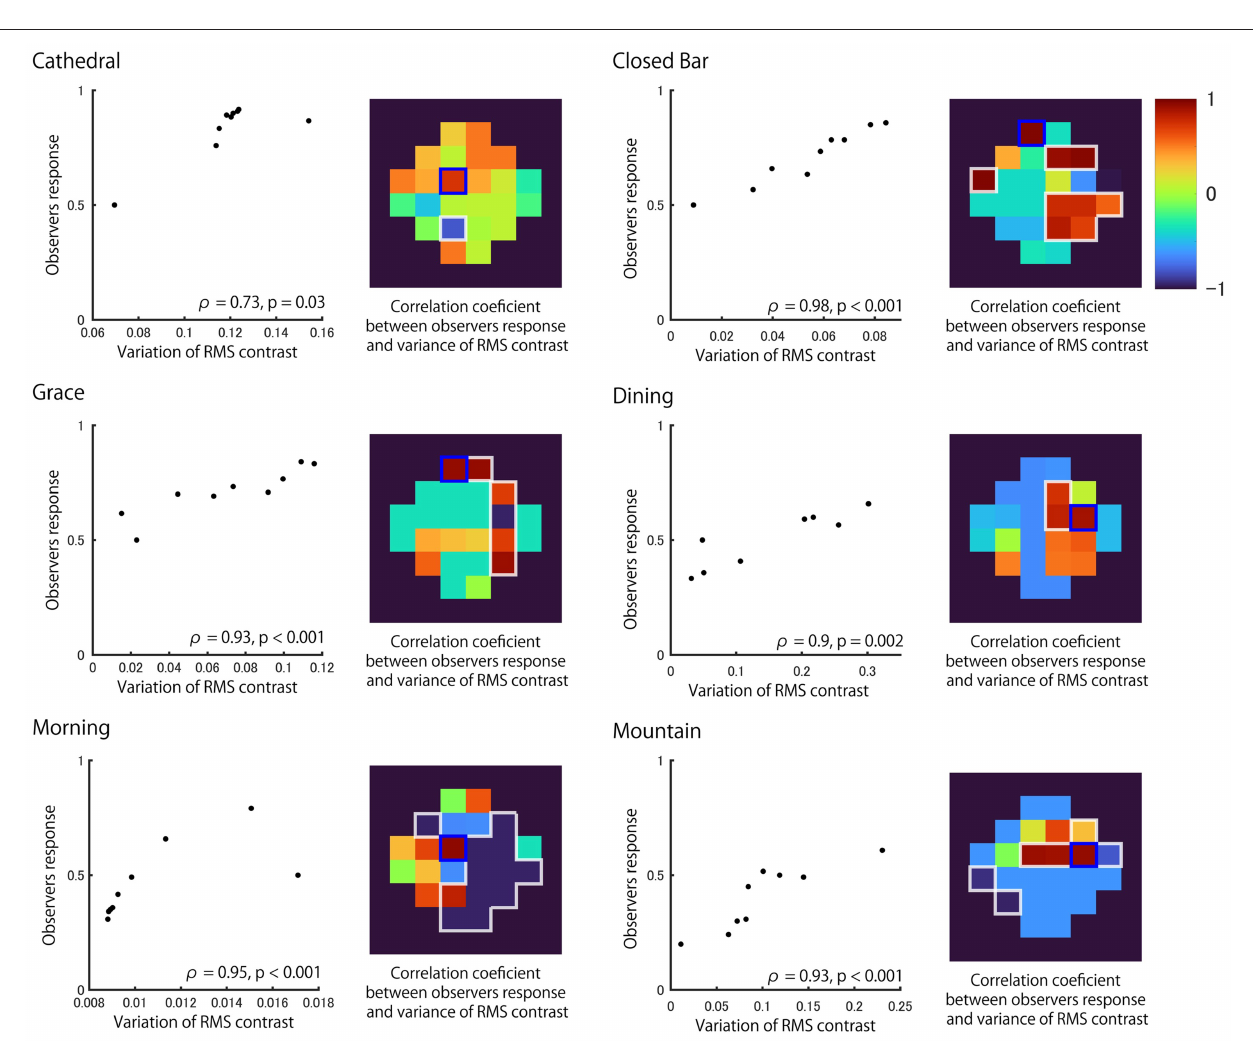
Frontiers in Psychology |